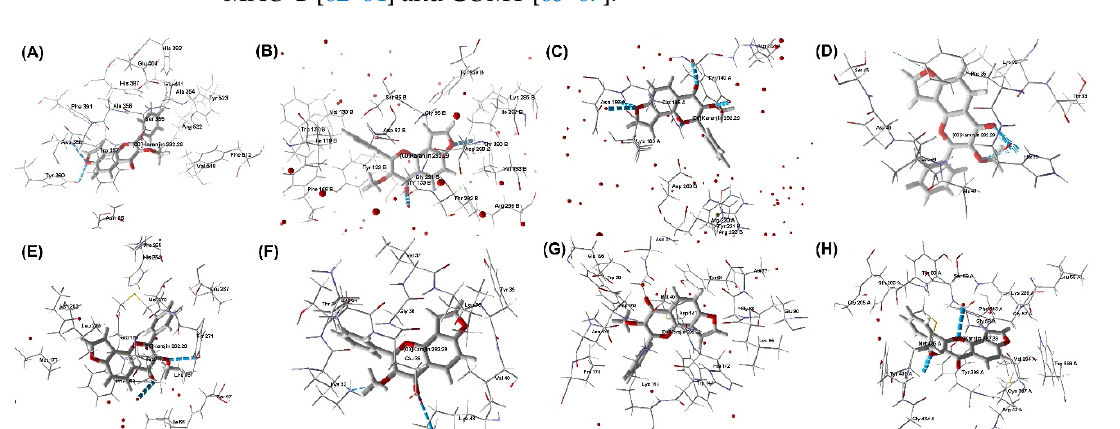
Figure 4. Molecular interactions of the natural karanjin against four putative drug targets of AD during study docking in 3D and 2D views (AutoDock); ( A & A ′ ) interaction against A 2A AR (PDB ID: 3EML); ( B & B ′ ) interaction against ASN (PDB ID: 1XQ8); ( C & C ′ ) interaction against COMT (PDB ID: 1H1D); and ( D & D ′ ) interaction against MAO_B (PDB ID:2C65), respectively. The 3D and 2D images were generated using the software Discovery Studio Visualizer. The grey spheres repre- sent the ligand (karanjin), and the arrows indicate the interaction of the karanjin with the amino residues present in the protein. The green colored line indicates the hydrogen bond interaction with the amino acid residues.